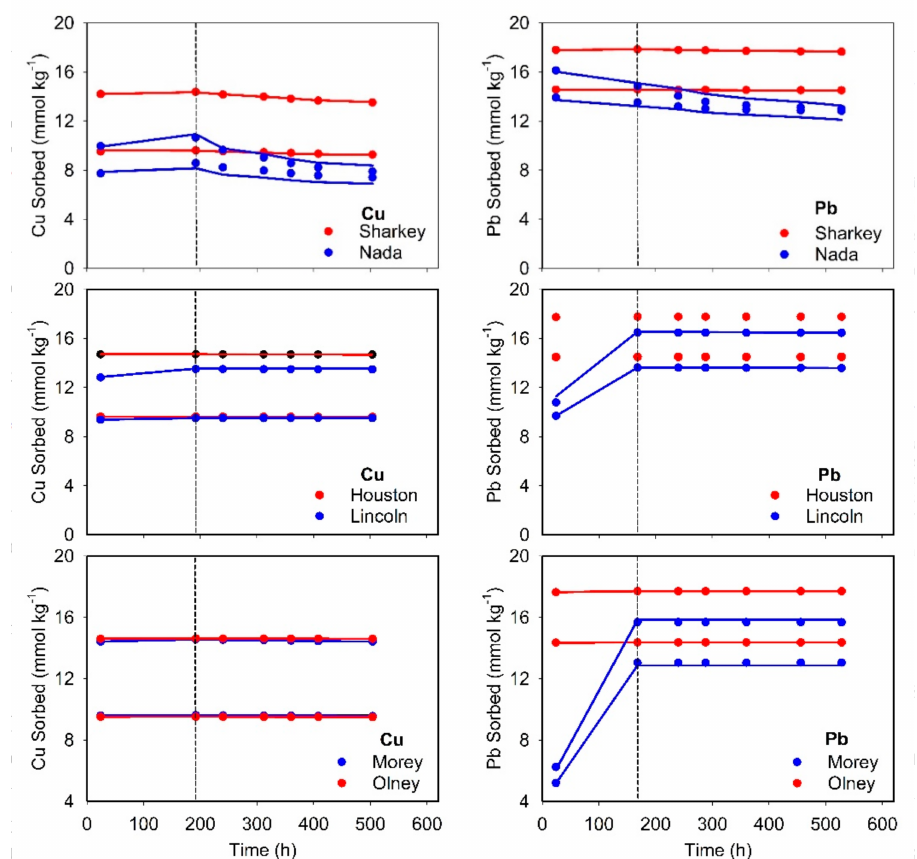
Figure 3. Sorbed Cu and Pb vs. time during sorption / desorption on di ff erent studied soils. Solid curves represent multireaction model simulations and the vertical dashed line shows beginning of desorption